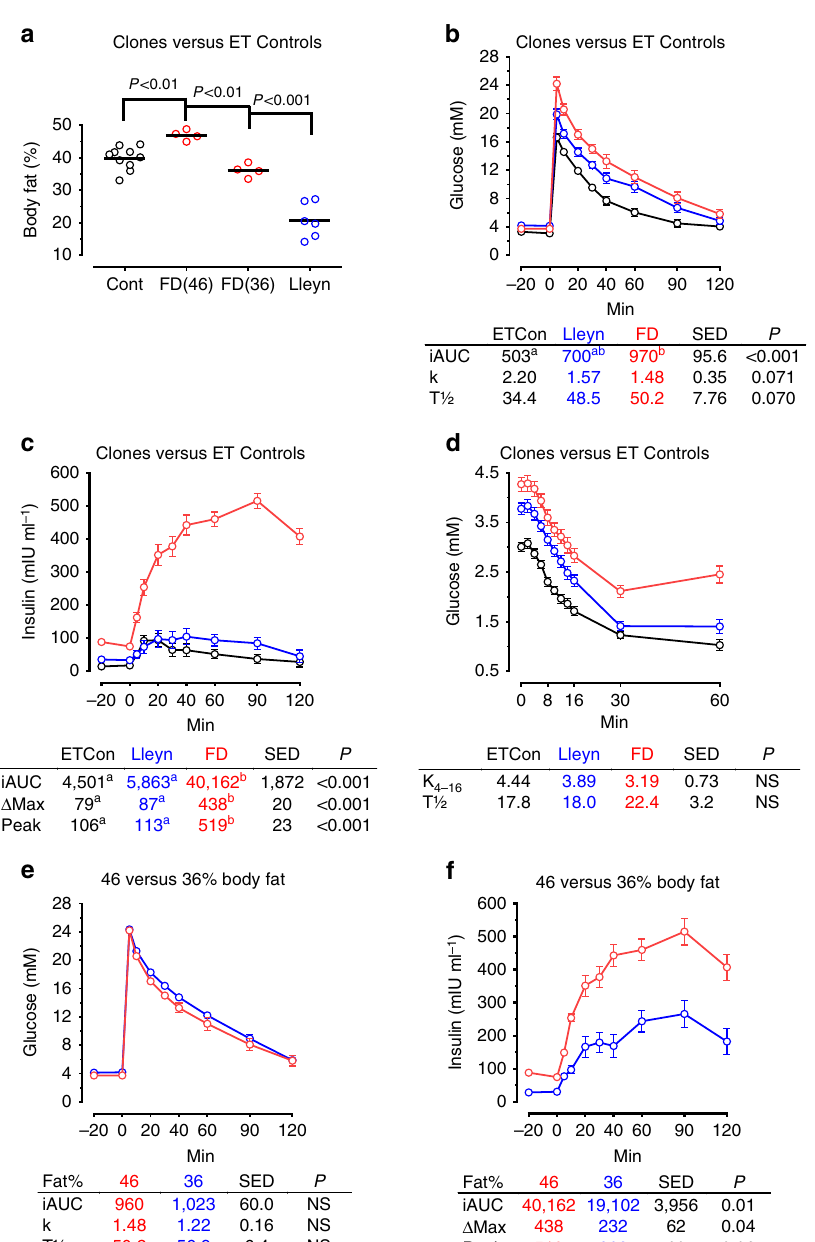
Figure 2 | Body fat, glucose tolerance and insulin sensitivity in aged cloned sheep and contemporary embryo transfer (ET) controls. Percentage body fat (determined by DEXA) revealed differences between clonal groups ( n ¼ 11 ET-Controls, 6 Lleyn and 4 FD clones) ( a ). Finn-Dorset (FD) clones were subsequently placed on a diet to reduce body fat percentage from 46% (FD46) to 36% (FD36). Initial glucose tolerance tests revealed modest differences in glucose tolerance ( b ) and large differences in insulinaemia ( c ) between clonal groups that probably reflected genotype differences in body fat percentage and body fat distribution. Insulin sensitivity did not differ between clonal groups and ET-controls ( d ). Although glucose tolerance was unaltered ( e ), insulinaemia was significantly reduced when Finn-Dorset clones lost body fat ( f ). Glucose was infused i.v. at 0.4g (cid:4) kg (cid:2) 1 body weight and insulin at 0.75IUkg (cid:2) 1 body weight, both at time 0. iAUC, incremental area under curve; k, fractional clearance of glucose (%min (cid:2) 1 ); K 4-16 , % decline in glucosemin (cid:2) 1 from 4 to 16min; T½, half-life of glucose; D Max , peak insulin—basal insulin. s.e.d., standard error of difference; NS, not significant. Different superscripts denote significance at P o 0.05 following Bonferroni correction. NATURE COMMUNICATIONS|7:12359|DOI: